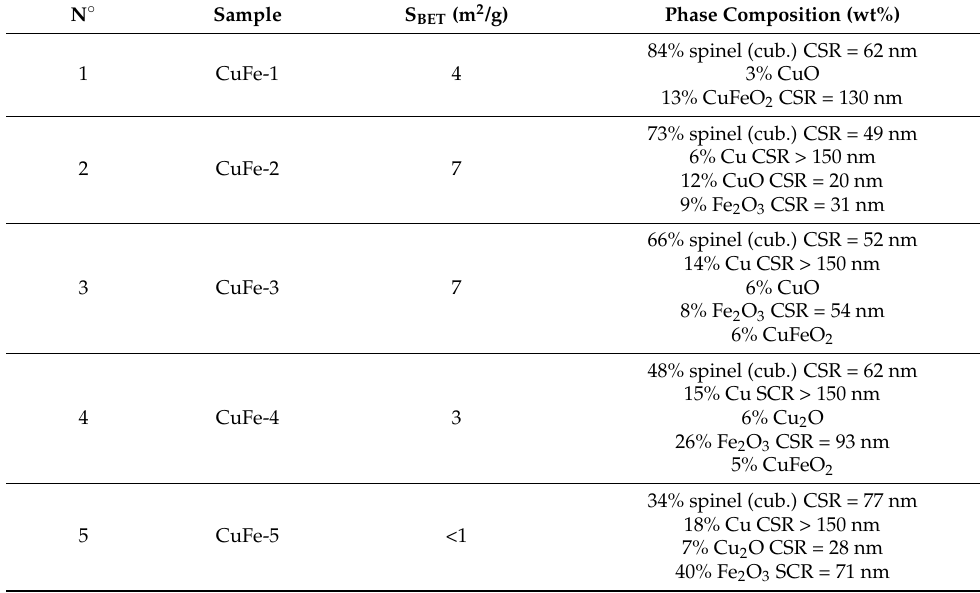
Table 2. The results of X-ray diffraction method and specific surface values for the different combus- tion products obtained in different